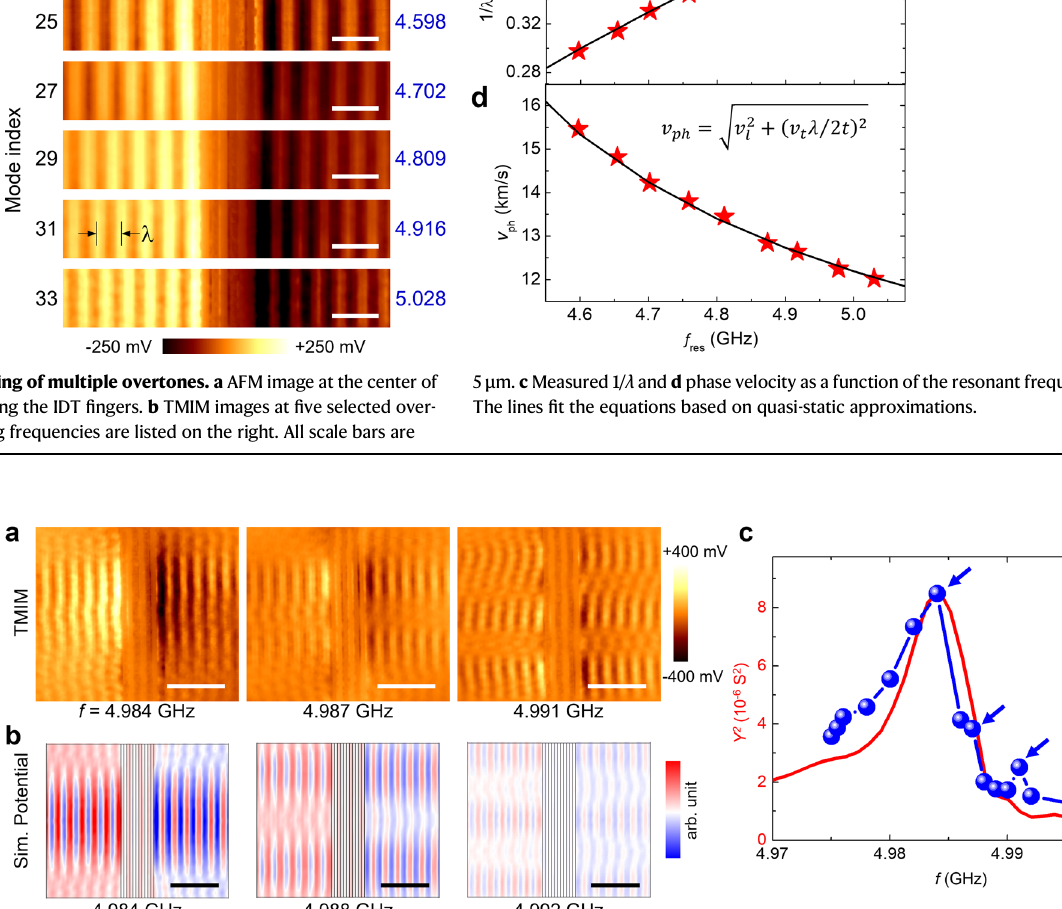
Fig.4|Higher-ordertransversemodesand Q -factor.a Lefttoright:TMIMimages corresponding to the fundamental, 2nd, and 3rd transverse modes of the 32nd overtone of the LOBAR device. b Simulated potential maps that match the experimentaldata.Theslightdifferenceinfrequenciesbetween( a )and( b )islikely due to uncertainties in device parameters. Note that the scanned area in a is